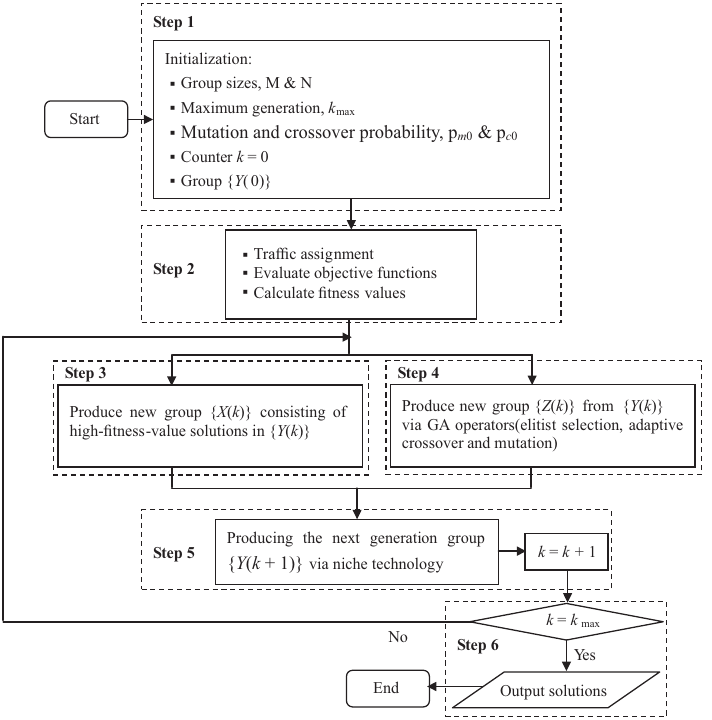
Fig. 3. Solution procedure for proposed bi-level